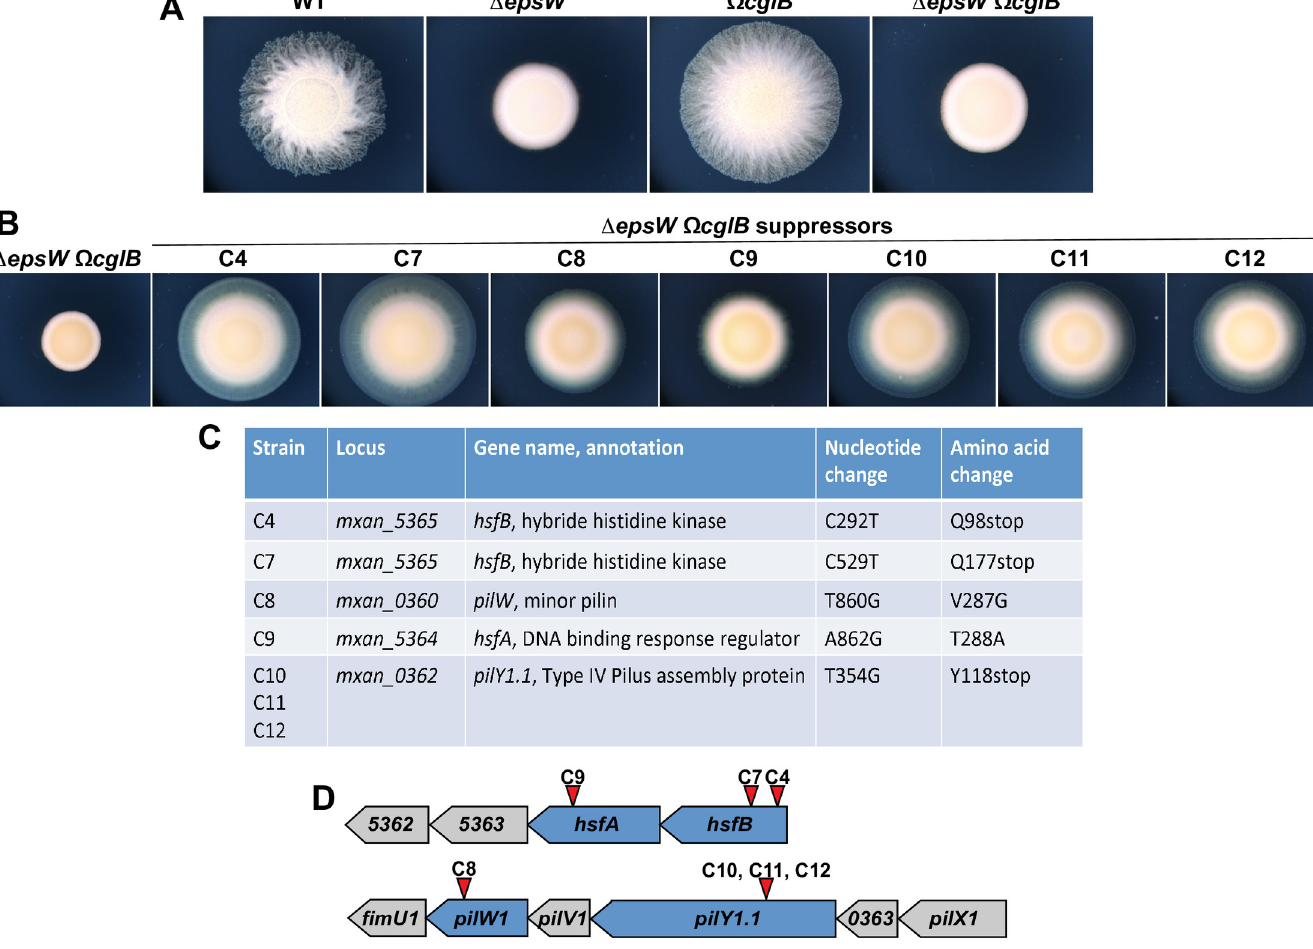
Fig 1. Seven suppressor mutants restore motility of a M . xanthus Δ epsW ΩcglB strain. (A) Motility phenotypic assays of DZ2 (wild type), EM650 ( Δ epsW ), TM770 ( ΩcglB ), EM749 ( Δ epsW ΩcglB ), EM785 ( Δ epsW ΩcglB sup4 ), EM788 ( Δ epsW ΩcglB sup7 ), EM789 ( Δ epsW ΩcglB sup8 ), EM790 ( Δ epsW ΩcglB sup9 ), EM791 ( Δ epsW ΩcglB sup10 ), EM792 ( Δ epsW ΩcglB sup11 ), EM793 ( Δ epsW ΩcglB sup12 ), on 0.5% agar and imaged at 48H (B) Motility phenotypic assays of seven suppressor mutants on 0.5% agar and imaged at 72H. (C) List of seven suppressor mutations. (D) Schematic representation of the M . xanthus genomic region containing the mxan_5362–5366 genes and mxan_0359–0364 genes. Red arrows represent the mutation